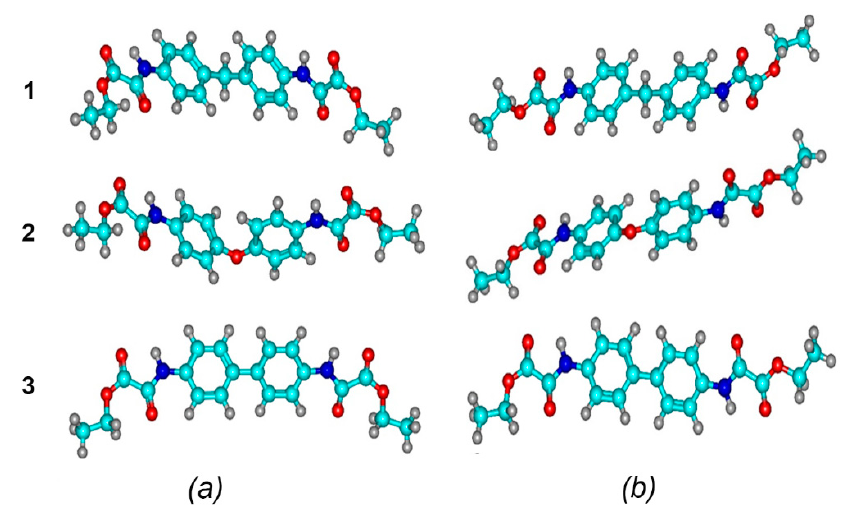
Figure 9. Optimized structures of 1 - 3 molecules in syn ( a ) and anti ( b ) conformation in the gas phase. Optimized structures were obtained at a ω B97X-D3/def2-TZVP level theory.